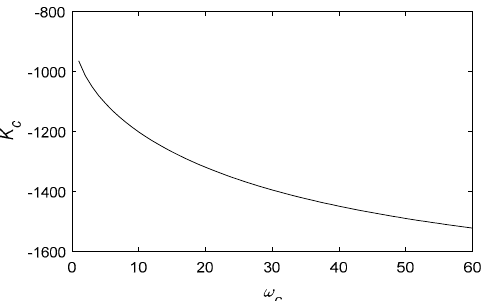
ω . Figure 13. System stability region under di c .